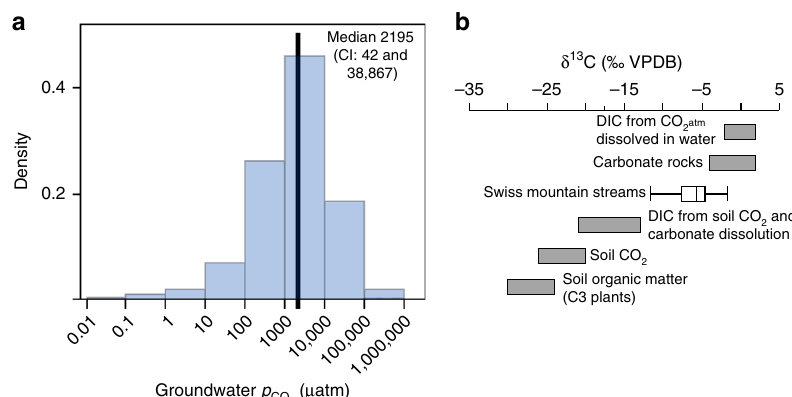
Fig. 2 Sources of CO 2 in streams in the Swiss Alps. a Estimated groundwater p CO 2 in Swiss mountain catchments. b Isotopic compositions of dissolved inorganic carbon ( δ 13 C-DIC) indicates biogenic (e.g., soil respiration) as well as geogenic sources (more enriched) ( ‰ Vienna Pee Dee Belemnite, VPDB). End-members are adopted from refs. 37,38 . The box plot shows median and quartile δ 13 C-DIC compositions repeatedly sampled across the 12 Swiss sites ( n = 134; 7 – 15 samples per stream) (calculated in JMP 13, SAS Institute Inc.,